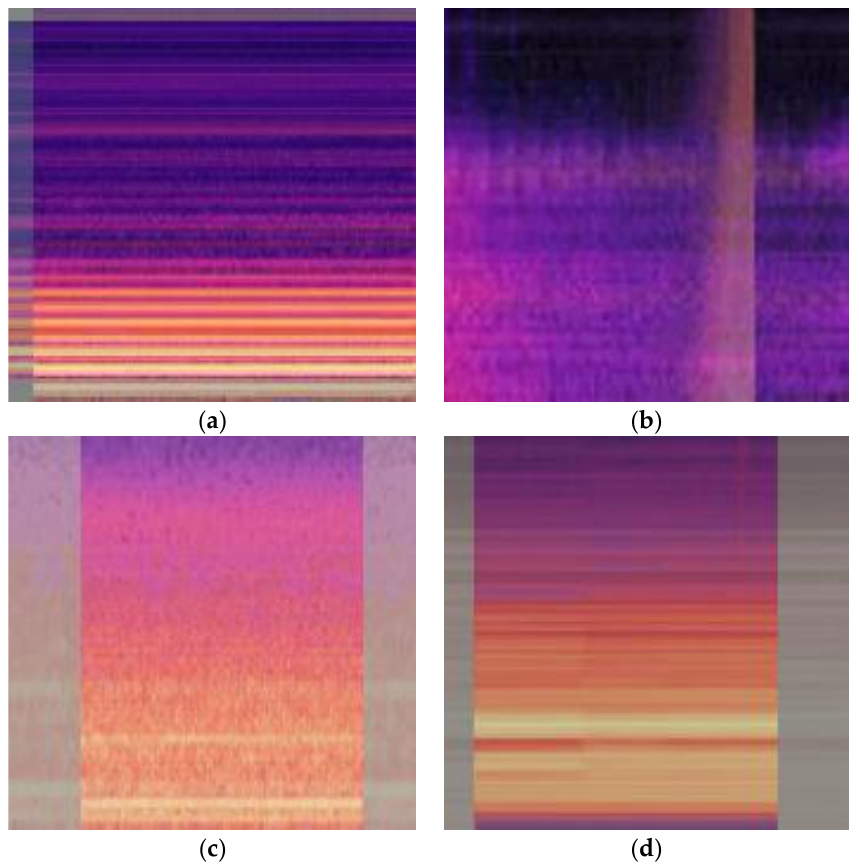
Figure 4. Mixup enhancement diagram: ( a ) Normal; ( b ) Short-circuit impulse; ( c ) Partial discharge; ( d ) DC bias.